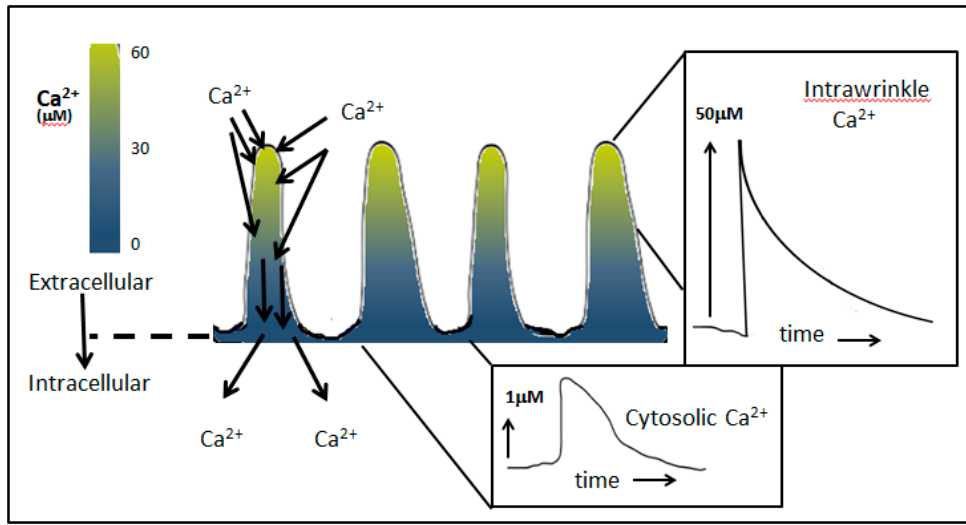
Figure 6. Intra-wrinkle Ca 2+ reaches a concentration high enough to activate µ -calpain. Mathematical modelling [78] shows that within the folded region of the plasma membrane, Ca 2+ concentrations reach very high levels, at least as high as that required for calpain activation. This is because the limited volume of the wrinkles has a relatively large surface area, so the effect of Ca 2+ influx is exaggerated within the wrinkle as compared to the whole cell. Once local Ca 2+ buffers within the cytosol of the wrinkles are saturated, the elevation of Ca 2+ is limited only by the rate of diffusion of new mobile Ca 2+ buffers into the wrinkle. The figure shows a pseudo-coloured representation of the Ca 2+ concentration, together with examples of the expected Ca 2+ transients within the wrinkle and within the cell.